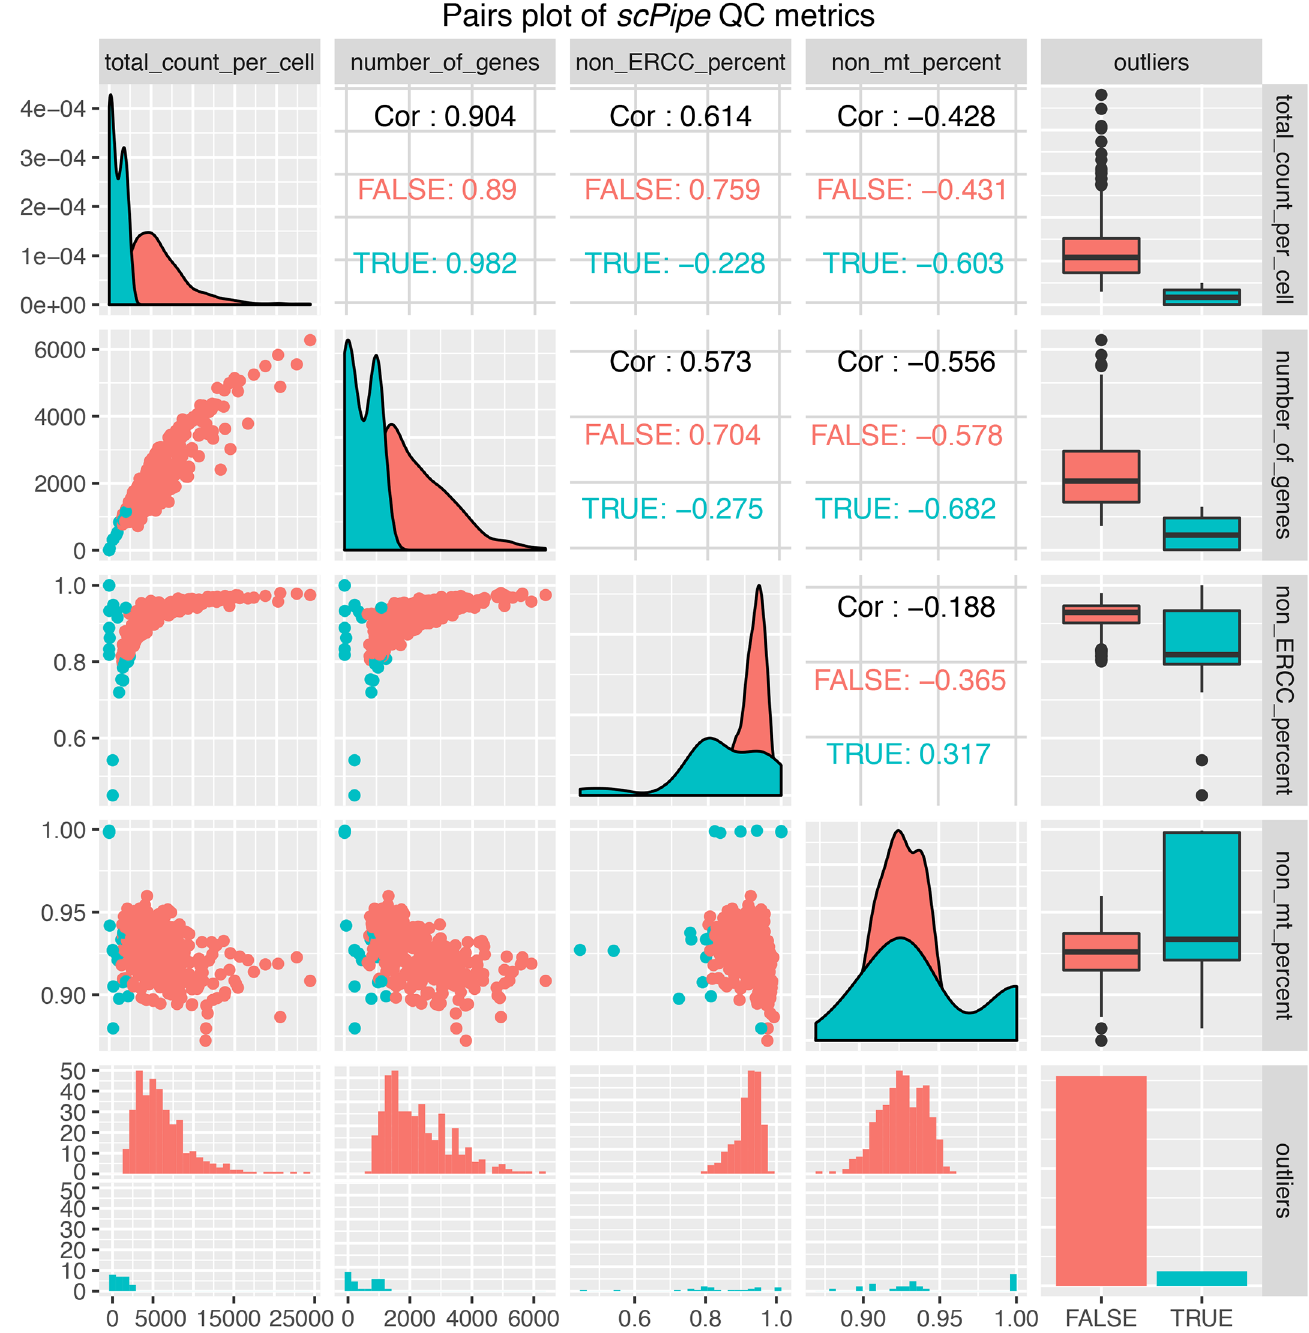
Fig 3. A pairwise scatter plot of the quality control metrics collected by scPipe for the mouse blood cell dataset. Sample-specific metrics include the total read count, the number of genes detected and the proportion of non-ERCC or non-mitocondrial reads. The good quality and outlier samples detected by scPipe ’s automatic outlier detection method are indicated in each panel by a different